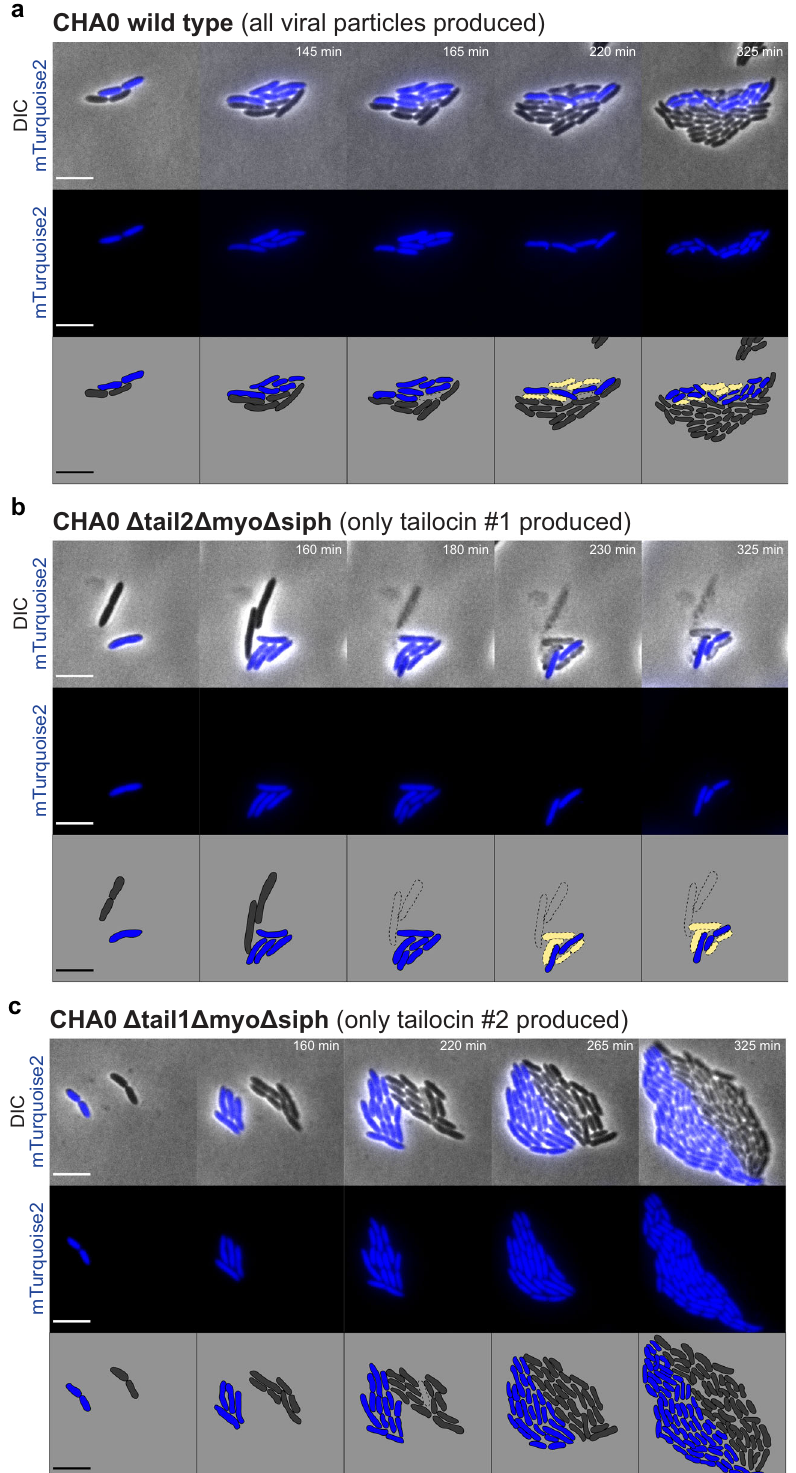
Fig. 6 Exclusive involvement of tailocin #1 of Pseudomonas protegens CHA0 during the direct competition against Pseudomonas protegens Pf-5 in non- induced conditions (i.e. no mitomycin C induction of CHA0). The competition between Pf-5 mTurquoise2 and a CHA0 wild type (Supplementary Movie 6), b the CHA0 mutant able to produce exclusively tailocin #1 ( Δ tail2 Δ myo Δ siph) (Supplementary Movie 7), or c the CHA0 mutant able to produce only tailocin #2 ( Δ tail1 Δ myo Δ siph) (Supplementary Movie 8) was followed by time-lapse microscopy. Cartoons outline the interaction at different time points. CHA0 and Pf-5 mTurquoise2 live cells are shown in gray and blue respectively. Ghost cells are outlined with a dotted line and are either not colored (CHA0) or fi lled with yellow (Pf-5). The scale bar represents 5 µ